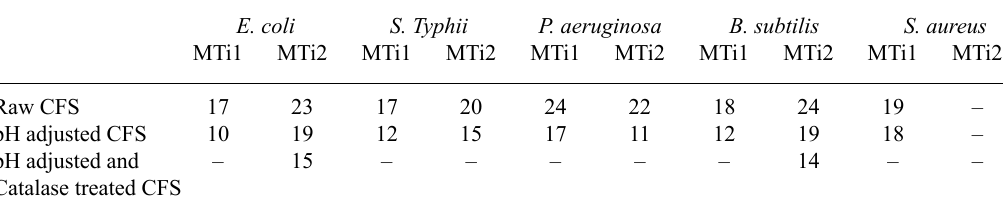
Table 2. Determination of reasons behind antibacterial activity of L. coryniformis subsp. torquens MTi1 and